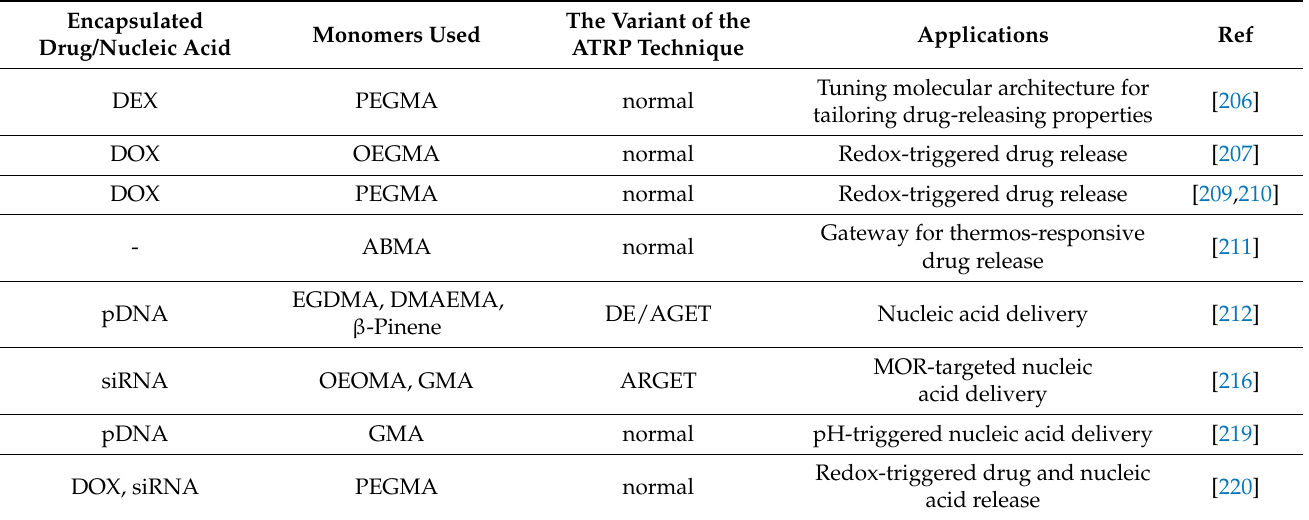
Table 3. A review of the literature on the synthesis of modern polymer combs and brushes using ATRP